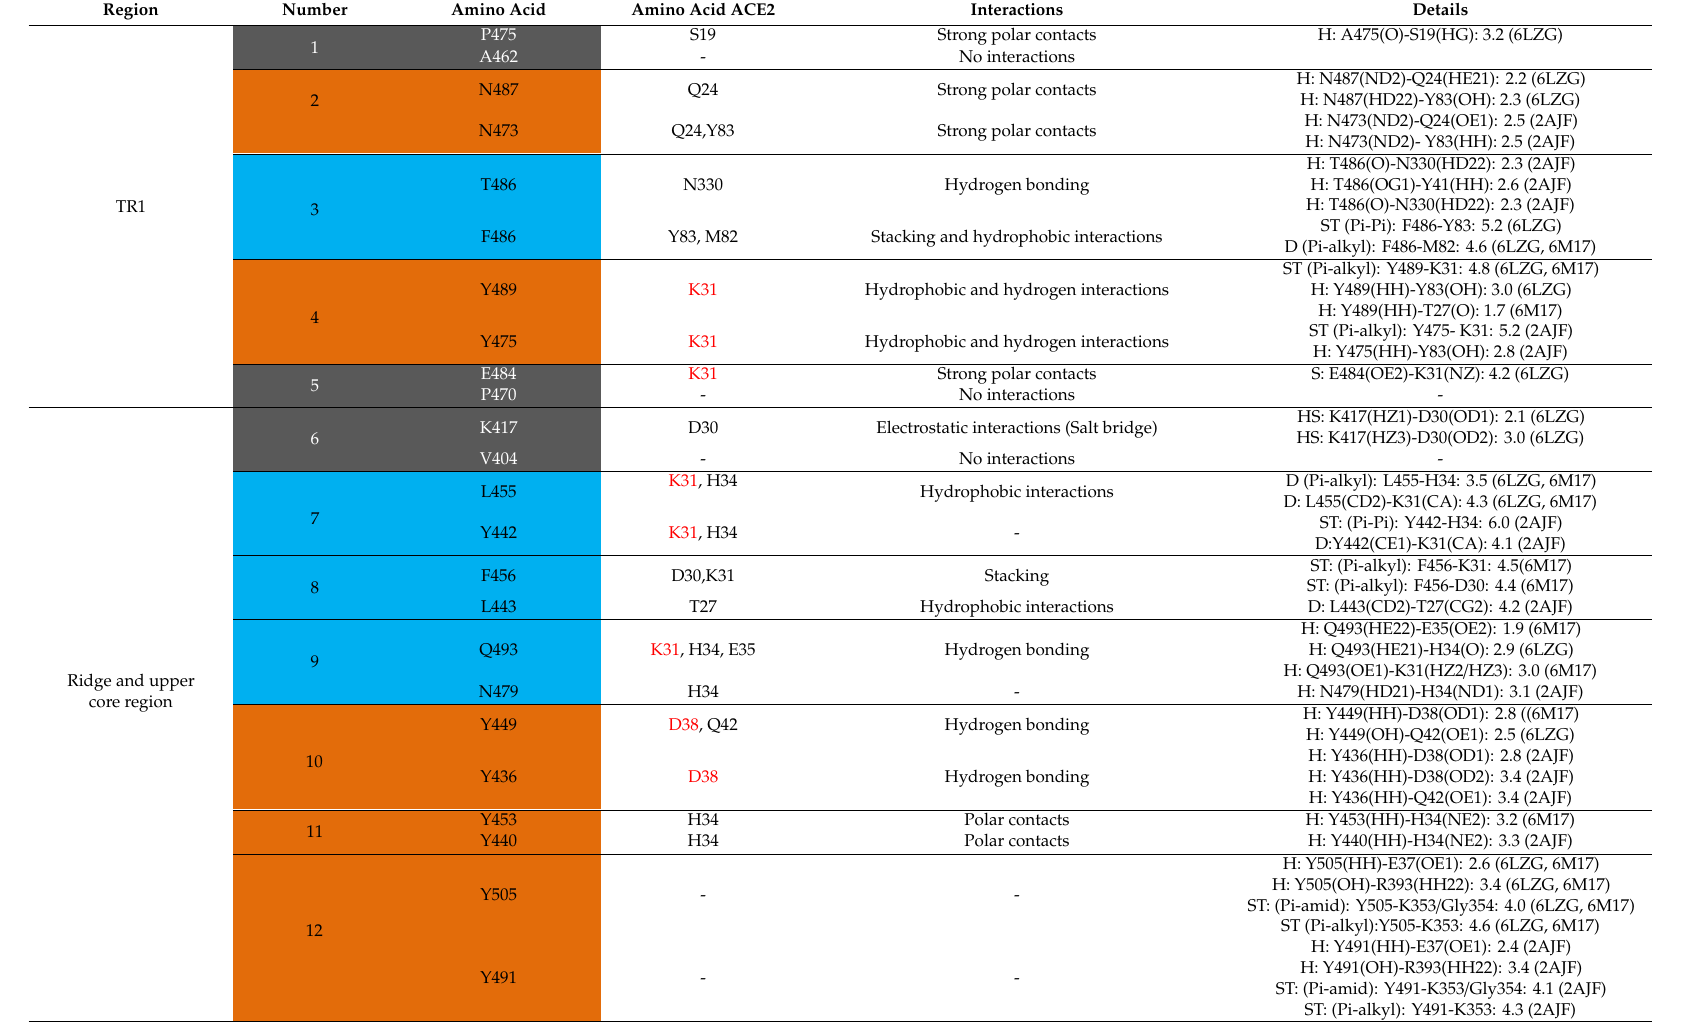
Table 3. Interactions between amino acids in the RBDs of SARS-CoV-2 and SARS-CoV with ACE2.